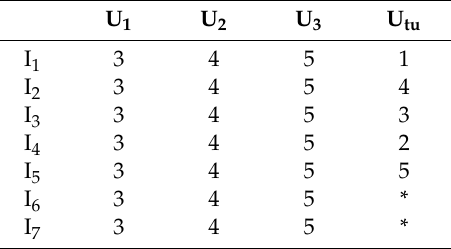
Table 1. Example of user-item rating matrix.